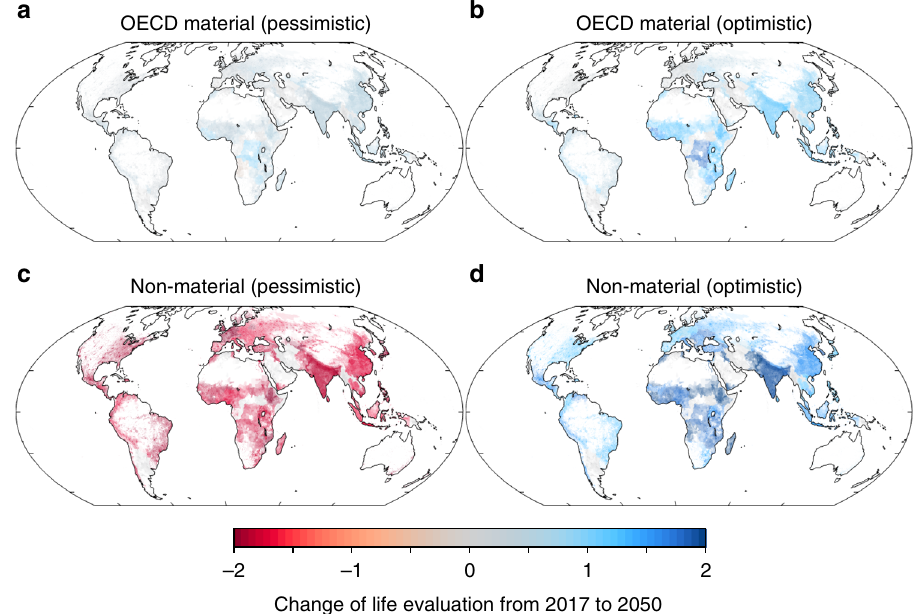
Fig. 3 Geographic distribution of feasible life evaluation changes. Projections for 2050 are for the OECD material growth scenarios ( a , b ), and scenarios in which the non-material predictor variables change at the 10th and 90th percentile rates of recent observations among all countries ( c , d ). Coef fi cients used in the projection are based on the two-period model of life evaluations. The shading on the map is weighted by projected population